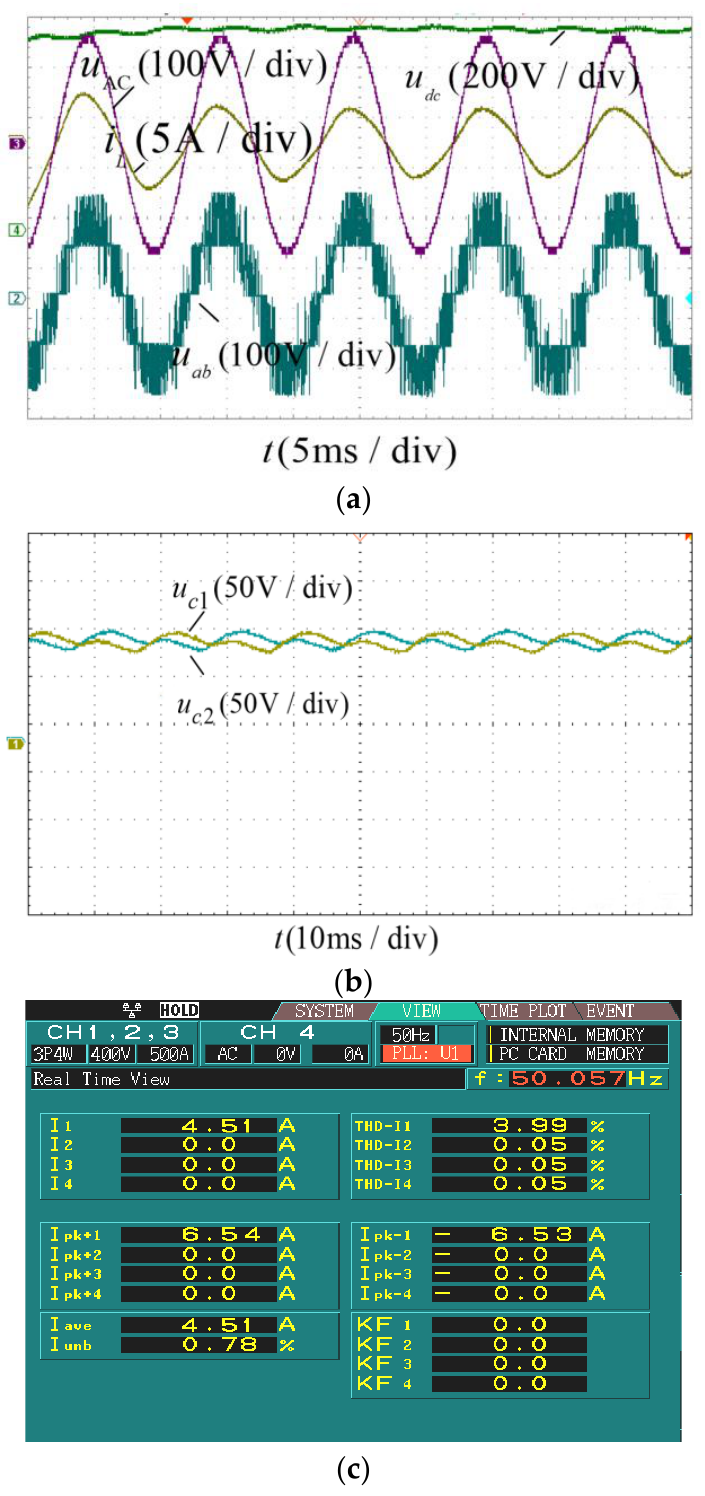
Figure 11. The experimental results in a steady state. ( a ) The DC output voltage u dc , the input voltage v AC , the inductor current i L , and the bridge-arm voltage u ab . ( b ) The capacitor voltage u c 1 , u c 2 . ( c ) Analysis of harmonic content.